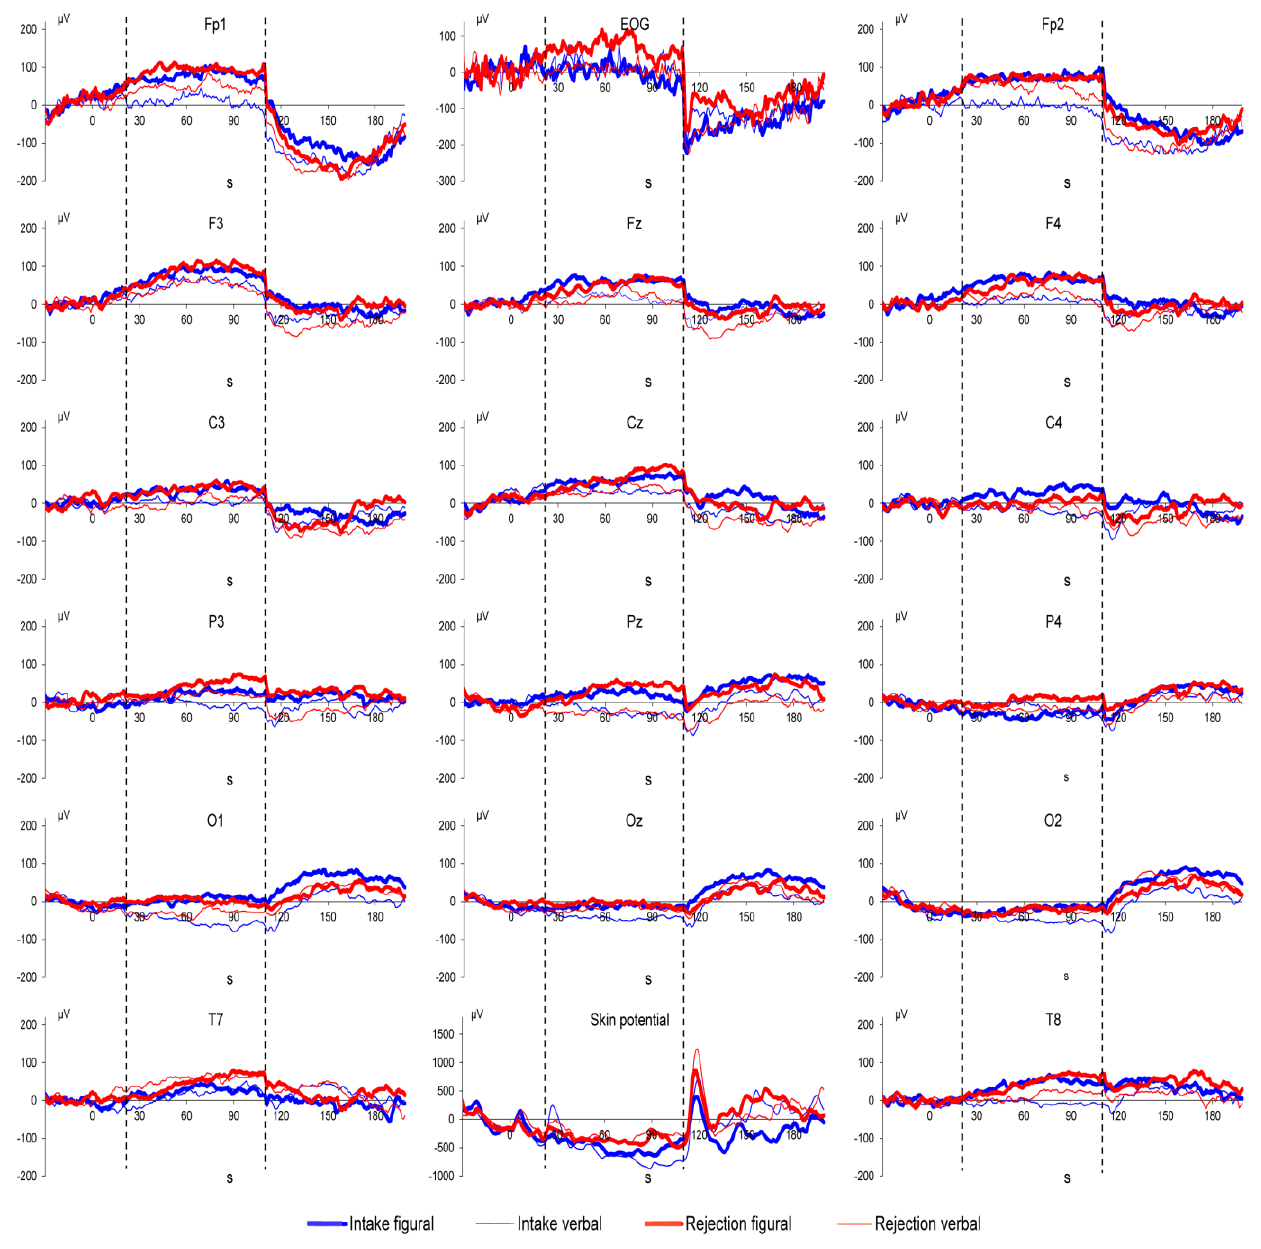
Figure 3. White noise-condition: Grand means of brain DC potentials (positivity upward) as well as vertical EOG and skin potential for the four attention task conditions. The timeline indicates when instructions (seconds 1–20), attention tasks (seconds 21–110; between the vertical broken lines), and examination of task execution (seconds 111–200) took